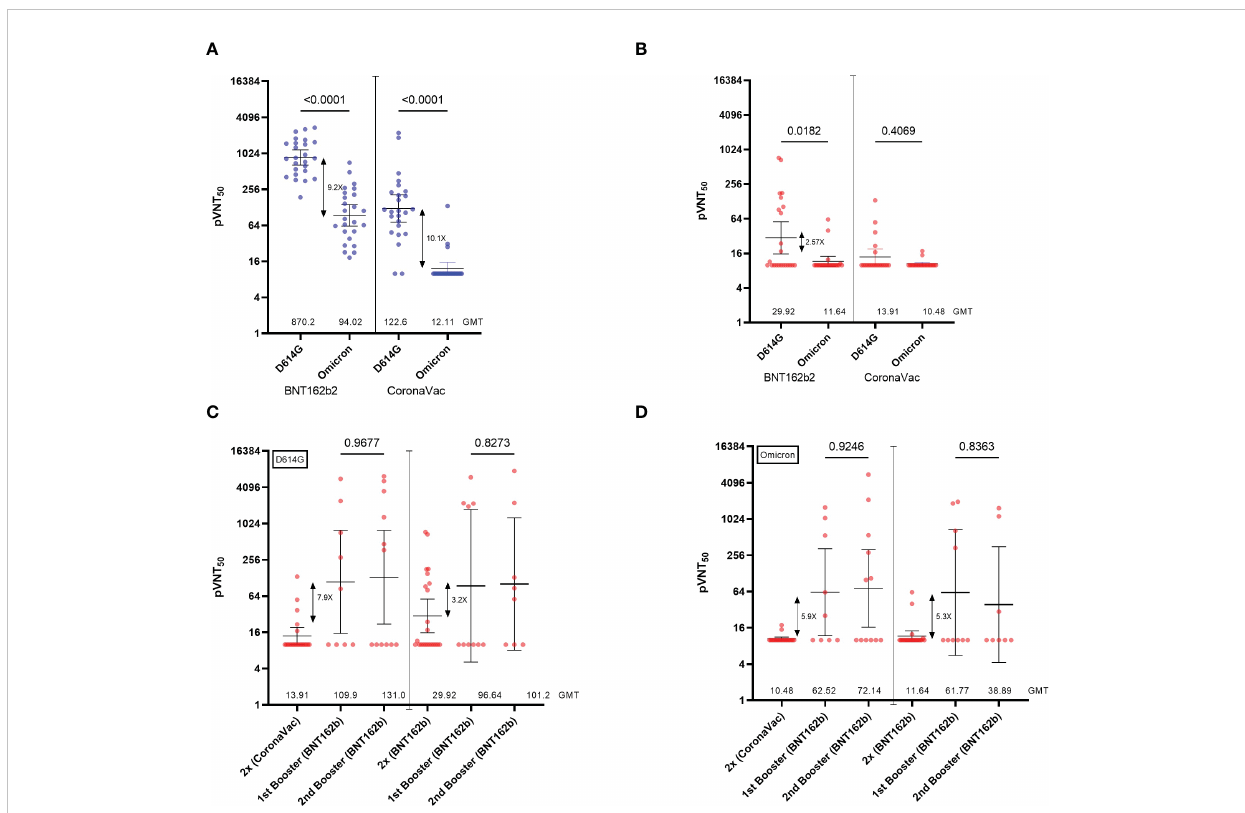
FIGURE 3 Neutralization titers of serum from SOTRs across the homologous and heterologous boosters. (A) 50% pseudovirus neutralization titers (pVNT 50 ) of 50 healthy recipients (blue) of the CoronaVac (n=25) and BNT162b2 (n=25) vaccines and (B) 44 SOT recipients (red) of the CoronaVac (n=21) and BNT162b2 (n=23) against pseudotypes ancestral reference strain (D614G) or Omicron (BA.1). (C, D) 50% pseudovirus neutralization titers (pVNT 50 ) of 44 SOT recipients of the CoronaVac (n=21; 1 st booster n=9, 2 nd booster n=12)) and BNT162b2 (n=23; 1 st booster n=10; 2 nd booster n=8)) against pseudotypes (C) ancestral reference strain (D614G) or (D) Omicron (BA.1). Geometric mean titers (GMTs) and 95% CIs are indicated. Factor changes are shown in brackets as the difference of the geometric mean titer in the pVNT 50 . Statistical signi fi cance of the difference between the